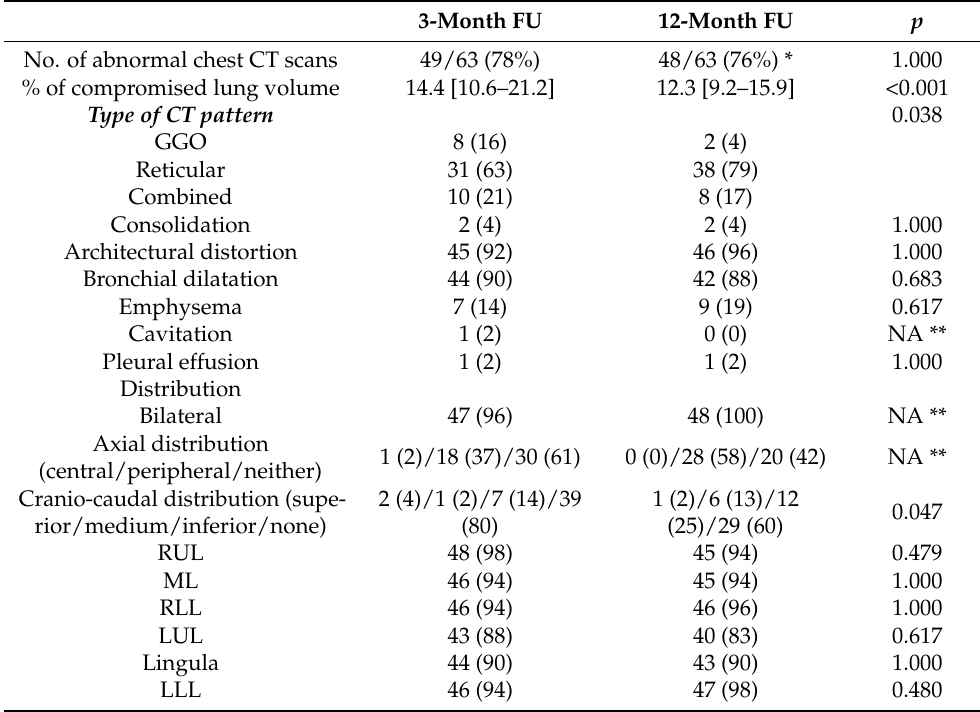
Table 3. Radiological findings in the COVID-19 survivors who underwent CT examination at three and 12 months after discharge and showed persistent chest CT abnormalities. Subclassification in improved/stably abnormal/worsened (group 3/4/5) is not considered in this